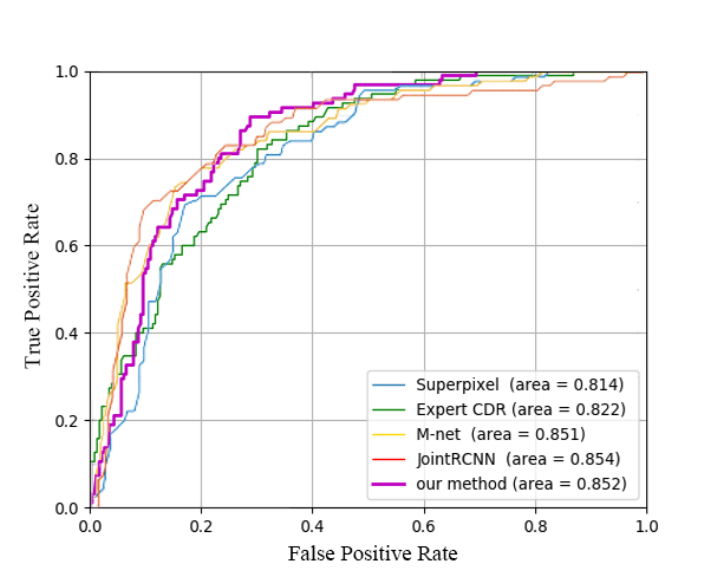
Figure 8. Comparison of ROC curves of different